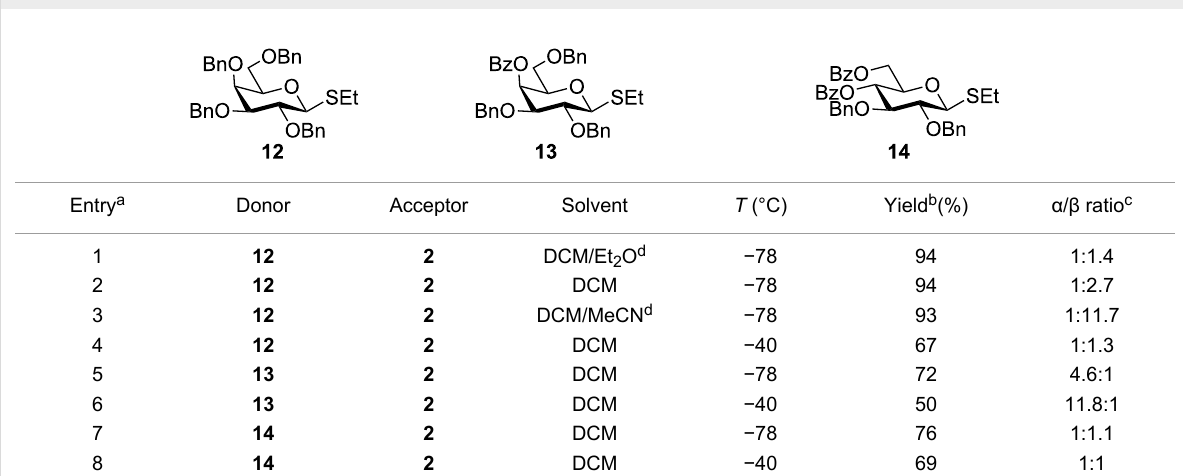
Table 3: 1,2- Cis -glycosylation activated by